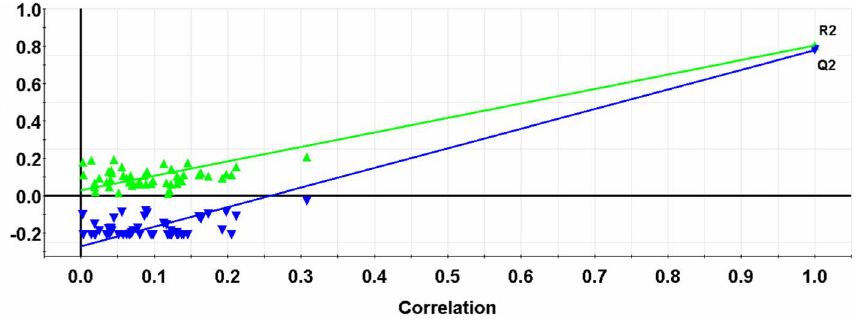
Figure 5. Plot of the 50-random-permutation validation for the GA-PLS model of ACE inhibitors. The intercepts of the R 2 - and Q 2 - lines with the ordinate axis are 0.029 and 2 0.270, which are below limits of R 2 , 0.300 and Q 2 , 0.050, respectively.